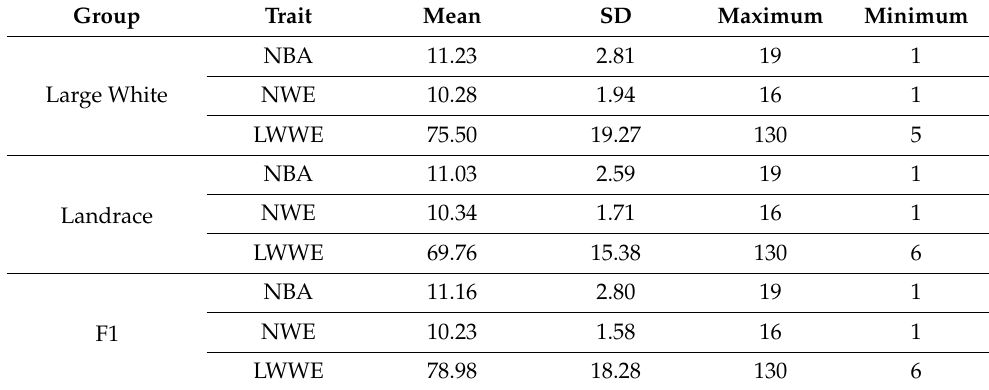
Table 3. Descriptive statistics of the measured